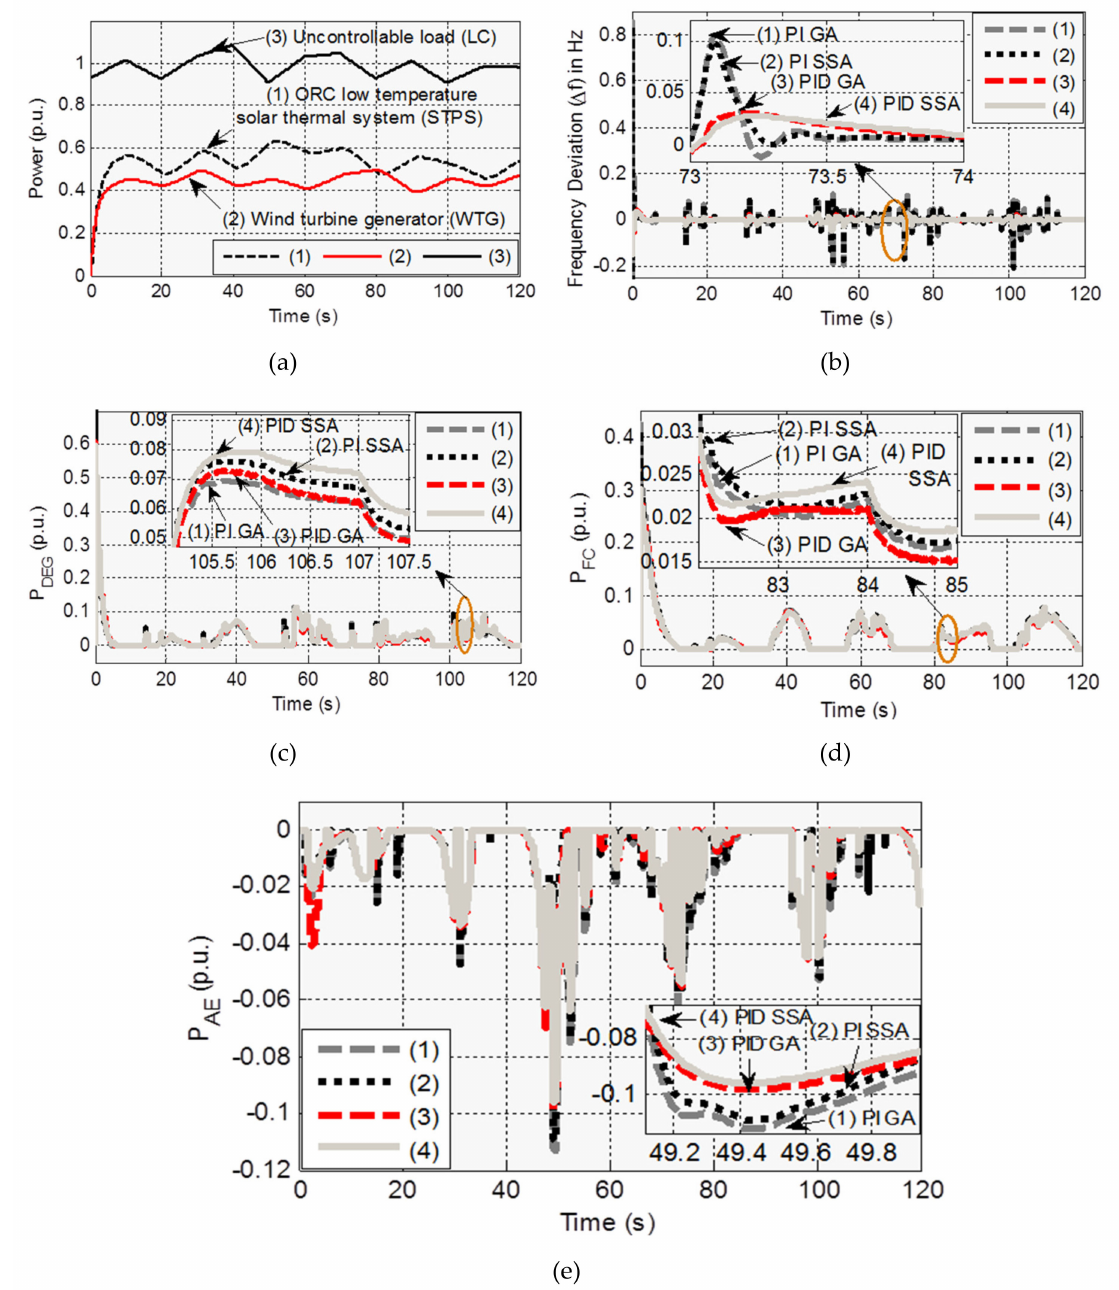
Figure 5. ( a ) Output power of the WTG, STPS and TCL . ( b ) GA- vs. SSA-optimized comparative frequency deviation with PBDR. ( c – e ) Comparative output power of the DEG , FC and AE with